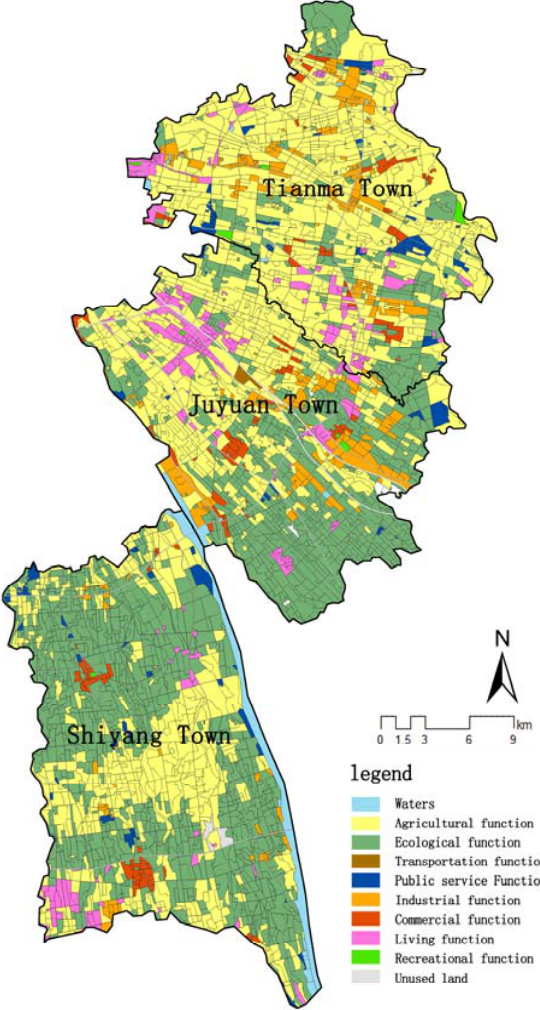
Figure 4. Results of spatial function recognition. Table 3. Area statistics of each function type.